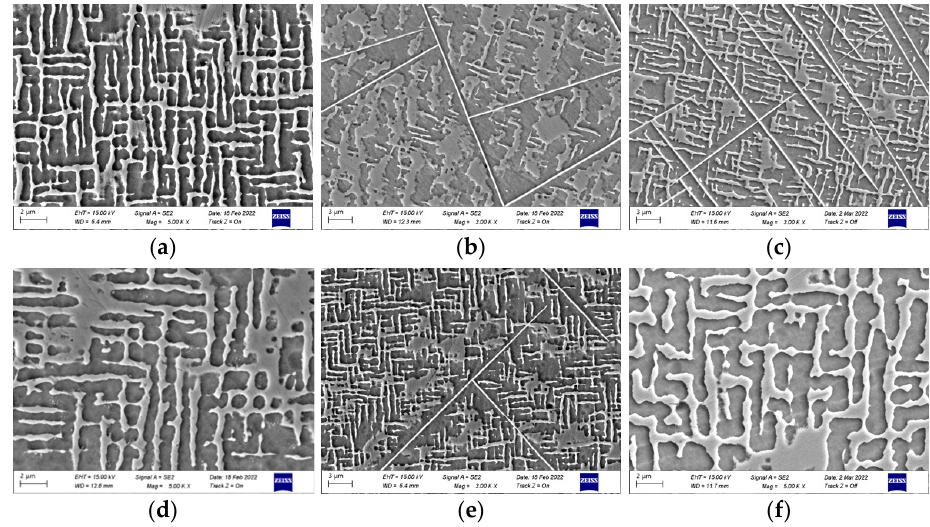
Figure 5. Microstructures of the alloy with different Co content after long-term aging at 1100 °C : ( a ) 200 h, 6% Co; ( b ) 400 h, 6% Co; ( c ) 1000 h, 6% Co; ( d ) 800 h, 9% Co; ( e ) 1000 h, 9% Co and ( f ) 1000 h, 12% Co.